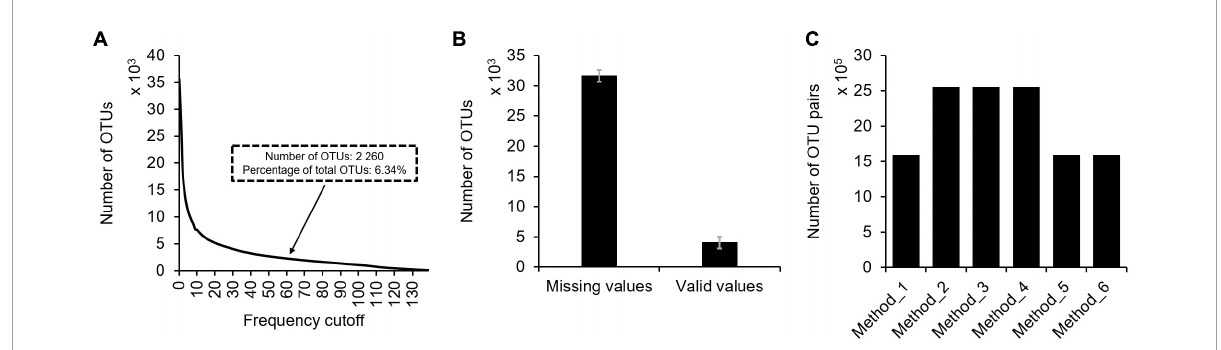
FIGURE3 The situation of missing values in typical microbial profiles. Using the TARA Oceans miTAG microbial profile as an example, the following information was shown: (A) The number of OTUs under different frequency cutoff. With 60 samples as the frequency cutoff, the number of detected OTUs was 2,260, accounting for 6.34% of all OTUs. (B) The average number of missing values and valid values present in each sample with standard error. (C) The number of OTU pairs suitable for correlation analyses using different data filtering methods.